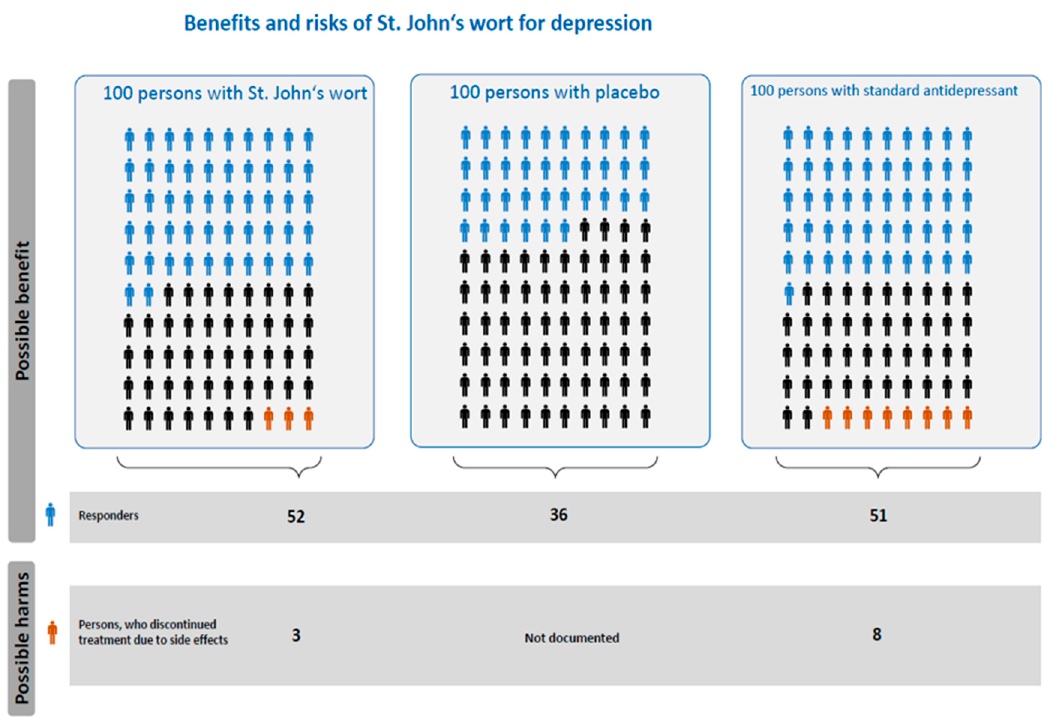
Figure 2. Icon array-graphic depiction of the Linde et al. (2008) Cochrane Review